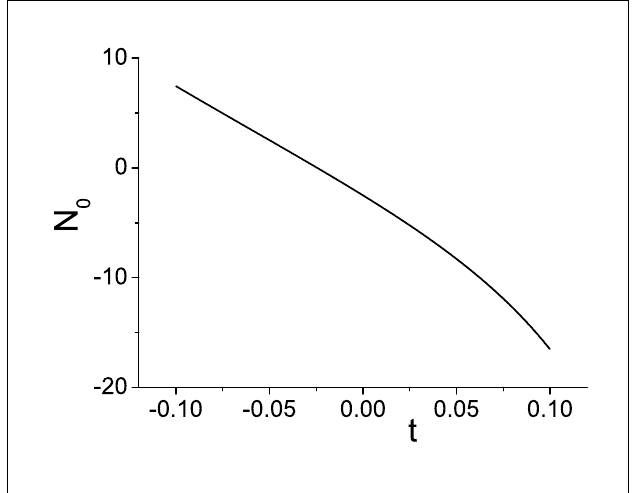
Figure 4. Reconstructed time-dependent part N 0 ( t ) related to the nonlinear connection for the nonholonomic basis under imposed bouncing scale factor Equation (24) with B (cid:3) 1 , in units where 8 π G (cid:3) 1